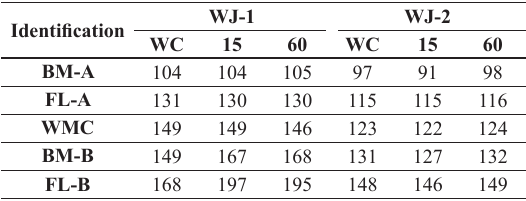
Figure 15. Correlation between deleterious phases precipition fraction and degree of sensitization for the WJ-1 and WJ-2 samples. Table 3. Nomenclature and distance of the regions of analysis of the samples.